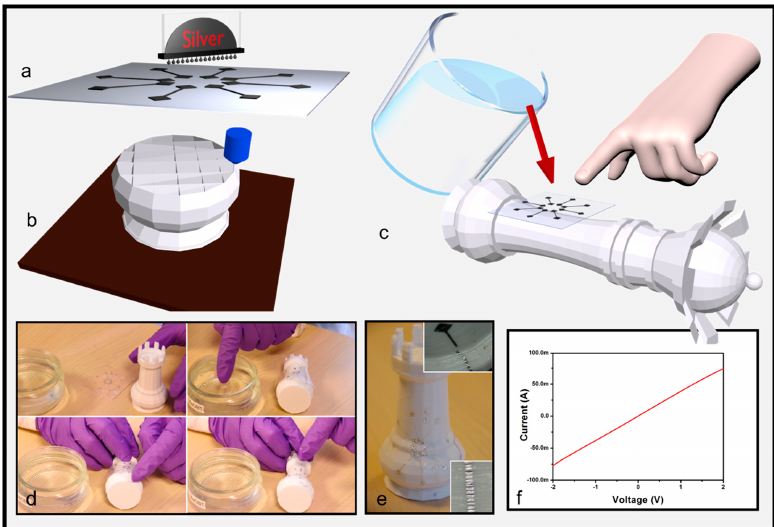
Figure 1. Electronics tattoo technology used to transfer interconnects onto object additively manufactured. Illustrations showing: ( a ) interconnects printed on water soluble substrate (poly-vinyl alcohol, PVA); ( b ) daily-life 3D object additively fabricated using fused deposition modeling (FDM); ( c ) water is applied on PVA substrate. The dissolution of PVA films helps to conformally wrap the 3D object with interconnects. Optical pictures showing: ( d ) the process; ( e ) a chess piece decorated with metallic ribbons arranged in star configurations. The bottom right inset shows ribbons conformally wrapped onto microscopically wave shaped surface (100 µ m amplitude). The top right inset shows that when ribbons are transferred onto macroscopic sharp edges, conformal wrapping cannot be obtained. ( f ) I(V)